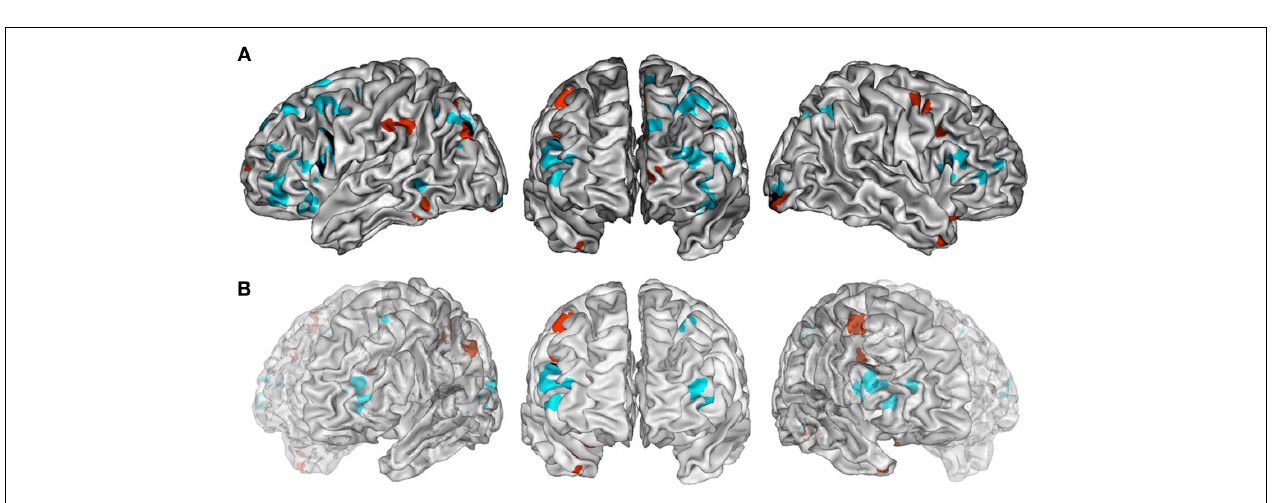
FIGURE 2 | (A) ALE maps of combination task foci (in cyan) and generation task foci (in red). Overlaps between maps are shown in black. All maps were thresholded at a whole-brain cluster-level corrected p < 0 . 05. (B) ALE maps resulting from contrast studies of combination vs. generation tasks foci (in